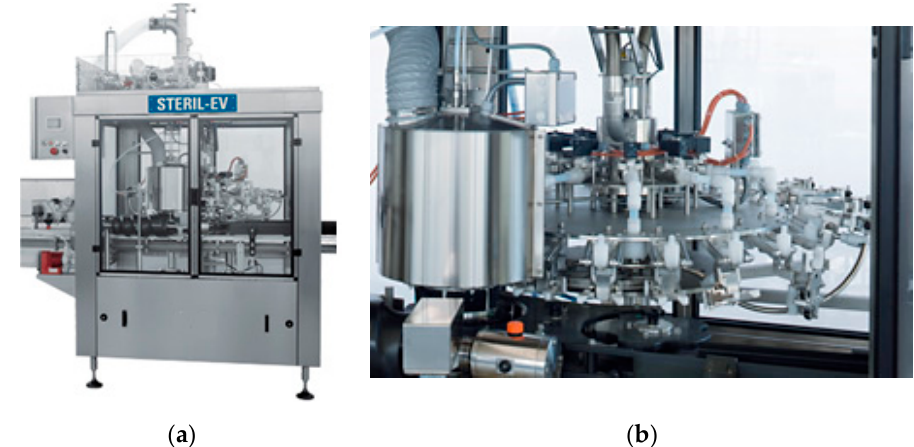
Figure 1. Example of a sterilizing machine for a bottling line: complete machine ( a ); rotating carousel ( b ). From www.promec-srl.com (accessed on 18 February